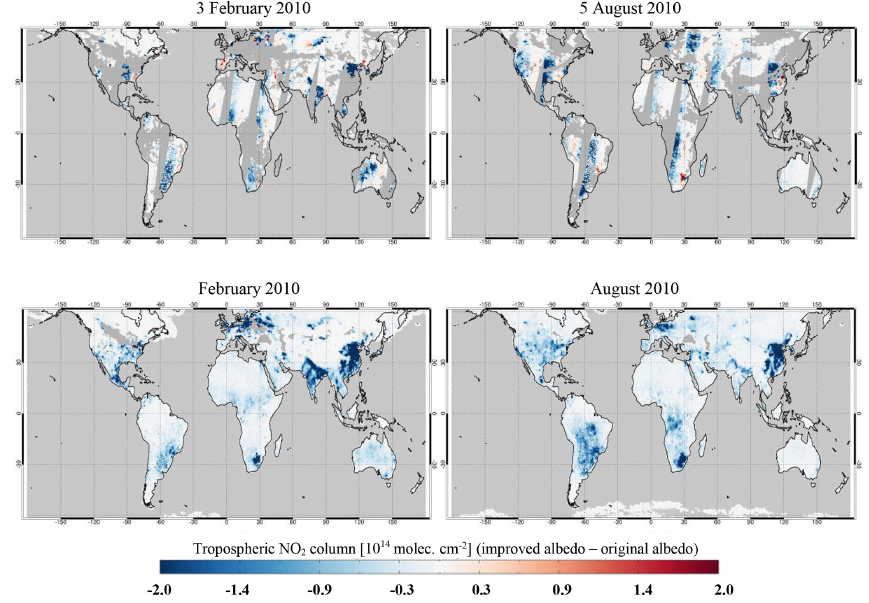
Figure 3. Differences in the GOME-2 tropospheric NO 2 columns retrieved using the GOME-2 LER and DLER datasets for a given day and for the monthly average in February and August 2010. Only measurements with a cloud radiance fraction less than 0.5 are included.